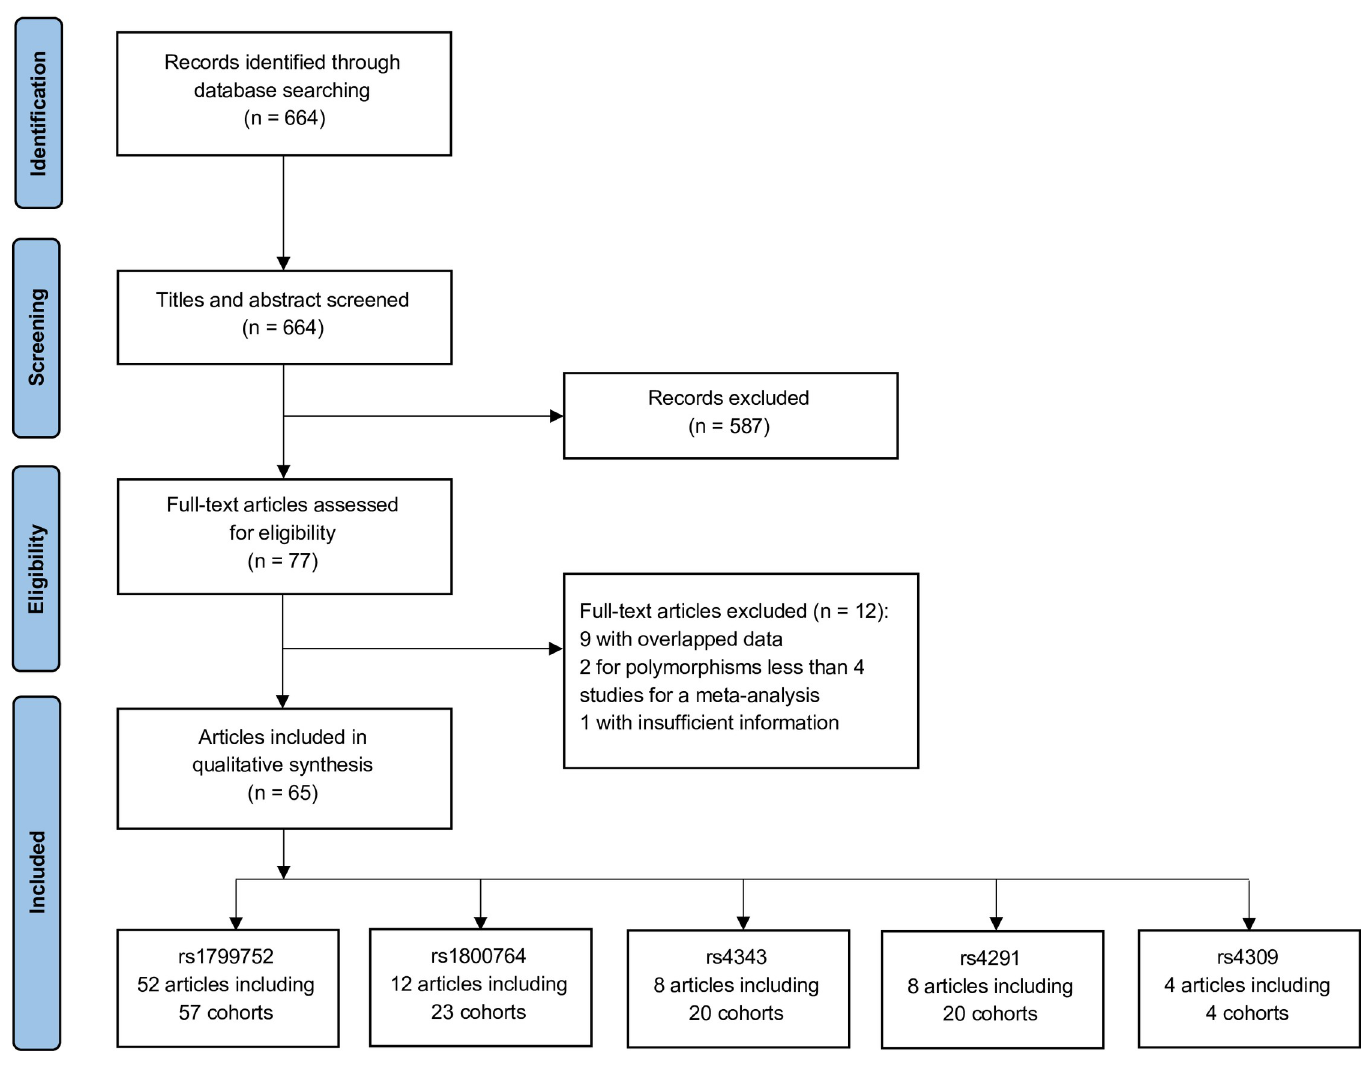
Fig 1. PRISMA flow diagram for literature search and study